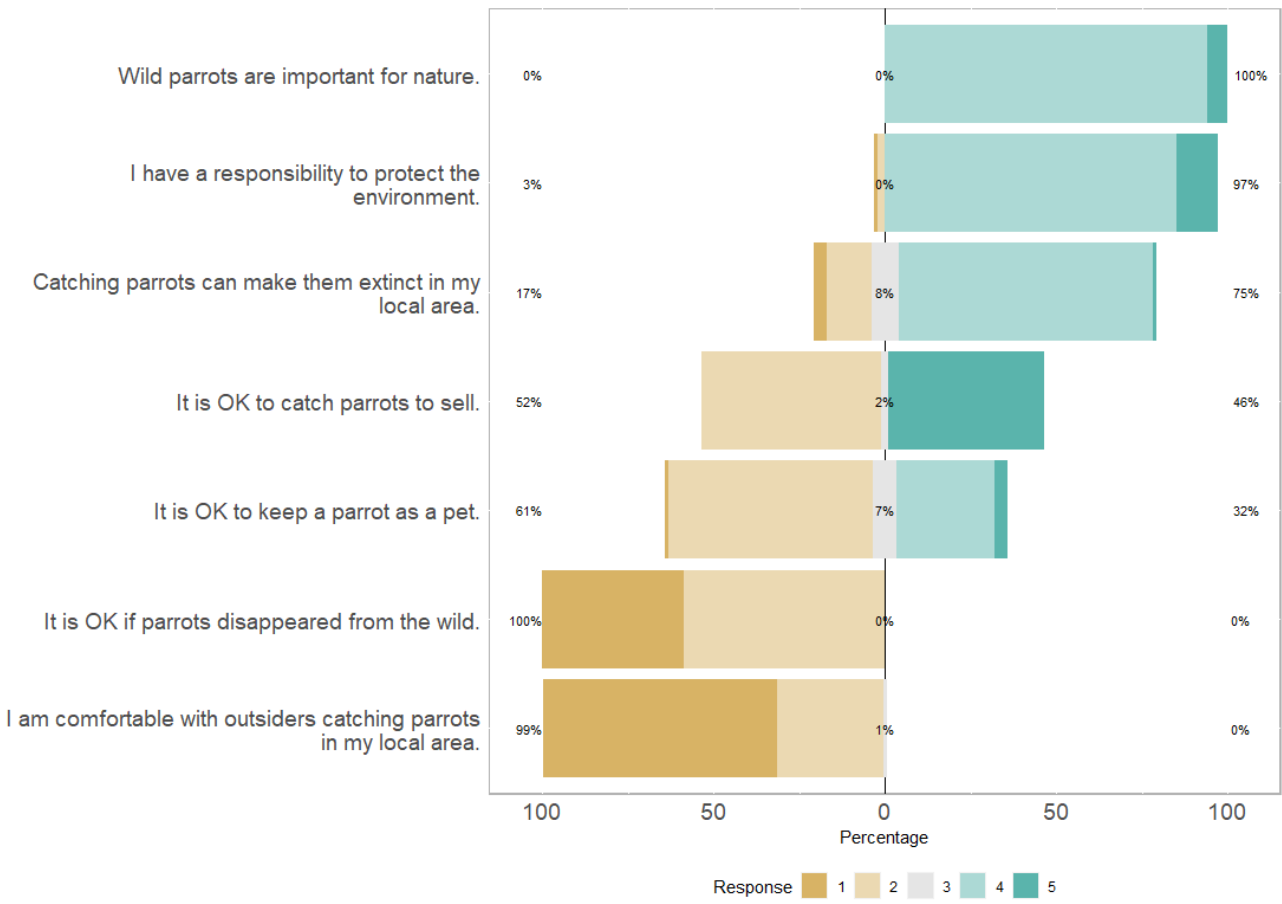
Figure 4. Responses to attitude statements are reported on a five point Likert scale (1 = strongly disagree, 2 = disagree, 3 = neutral, 4 = agree, 5 = strongly